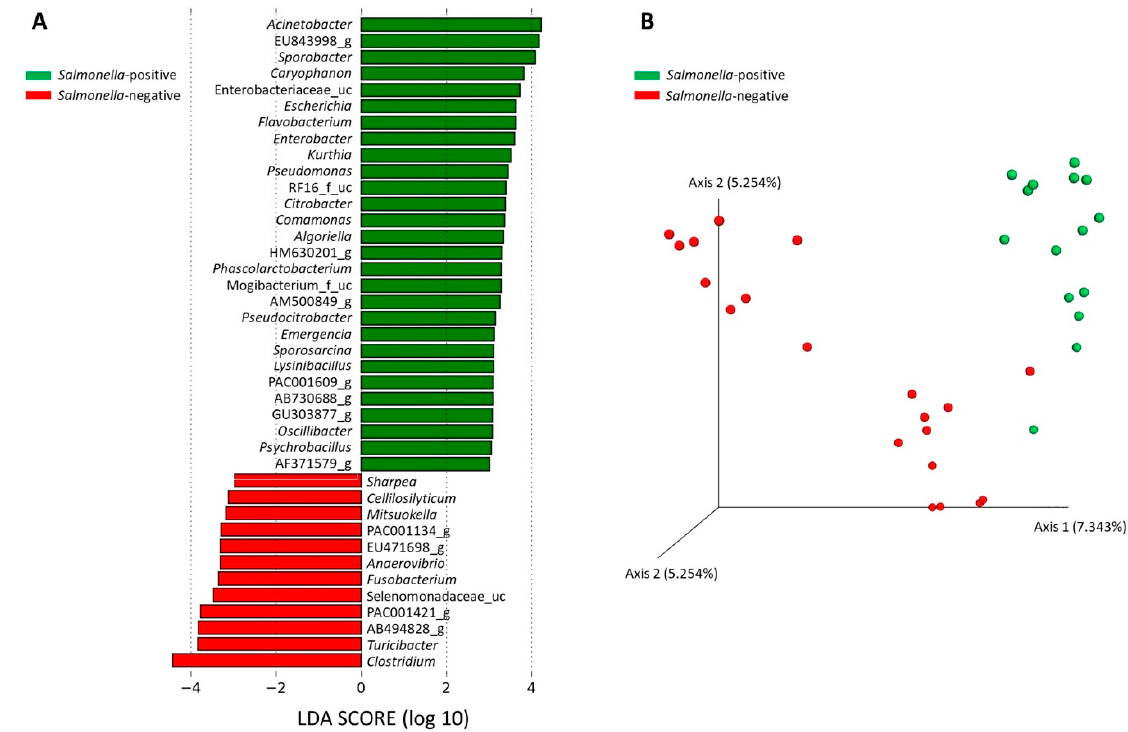
Figure 2. Differential bacterial taxa analysis in Salmonella -positive (green) and Salmonella -negative (red) groups. ( A ) Distinc- tive genera of each group obtained by LEfSe analysis (LDA score > 2.0; alpha value < 0.05). ( B ) Principal coordinate analysis (PCoA) graph based on UniFrac distances.